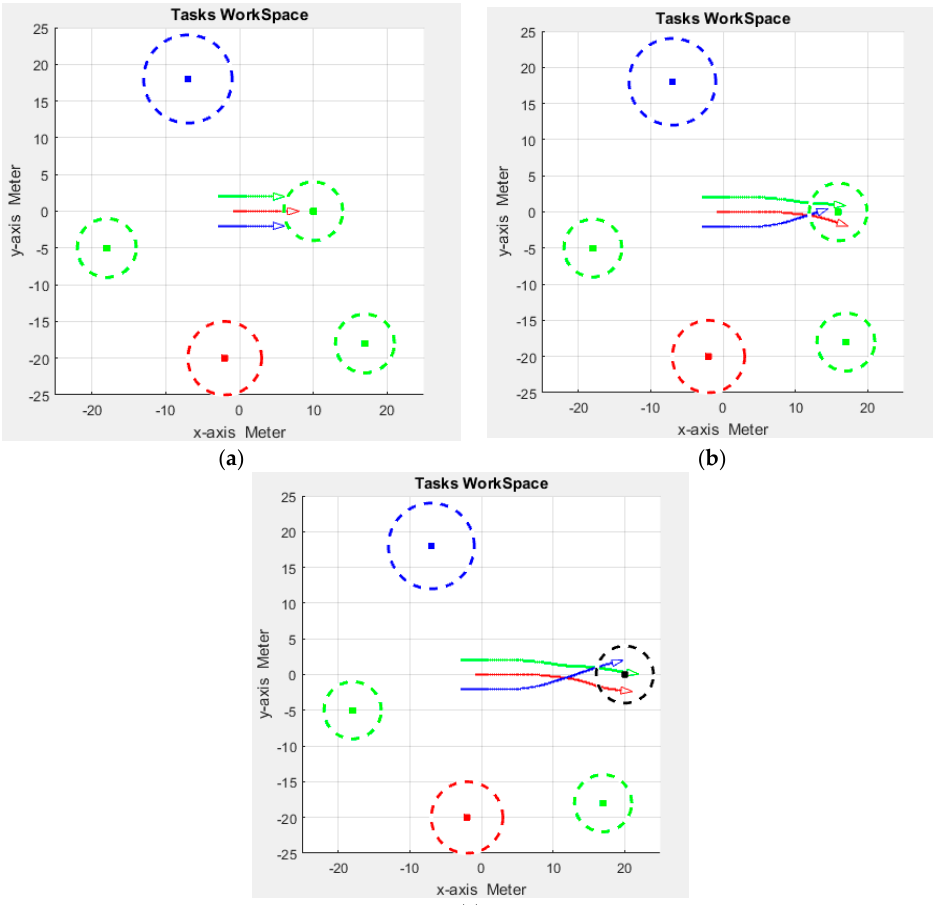
Figure 5. Scenario with dynamic target: ( a ) green moving target recognized; ( b ) green target being pursued by group of robots with green agents transitioning toward leader position; and ( c ) green target stopped and task executed by matching green leader